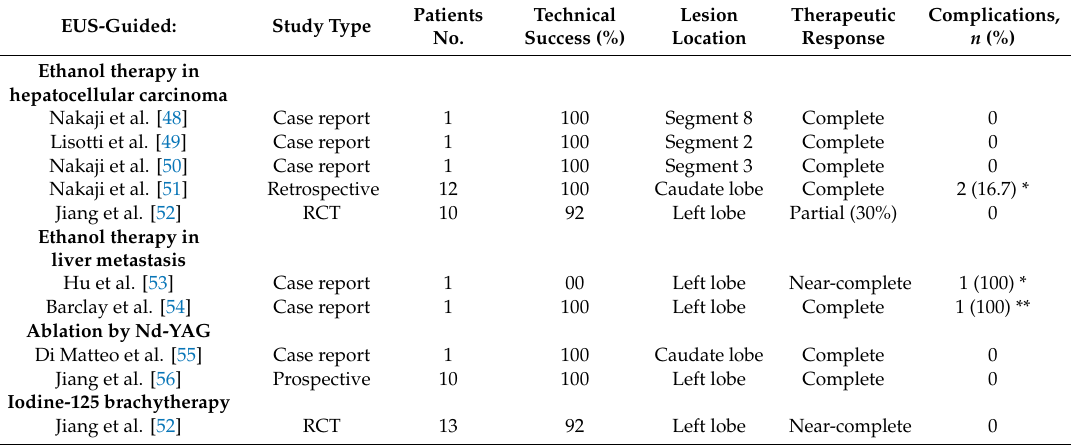
Table 2. EUS-guided available therapies for focal solid liver